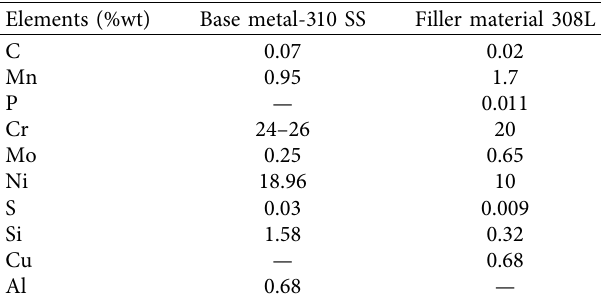
Table 1: Chemical composition materials.